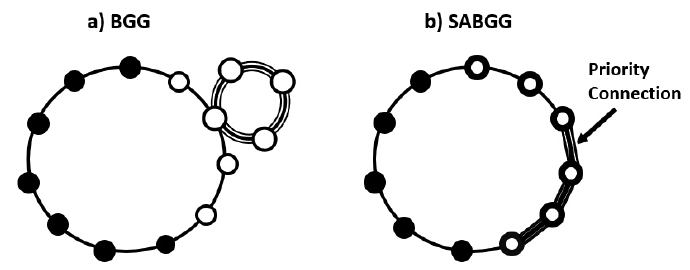
Figure 2. BGG vs. SABGG